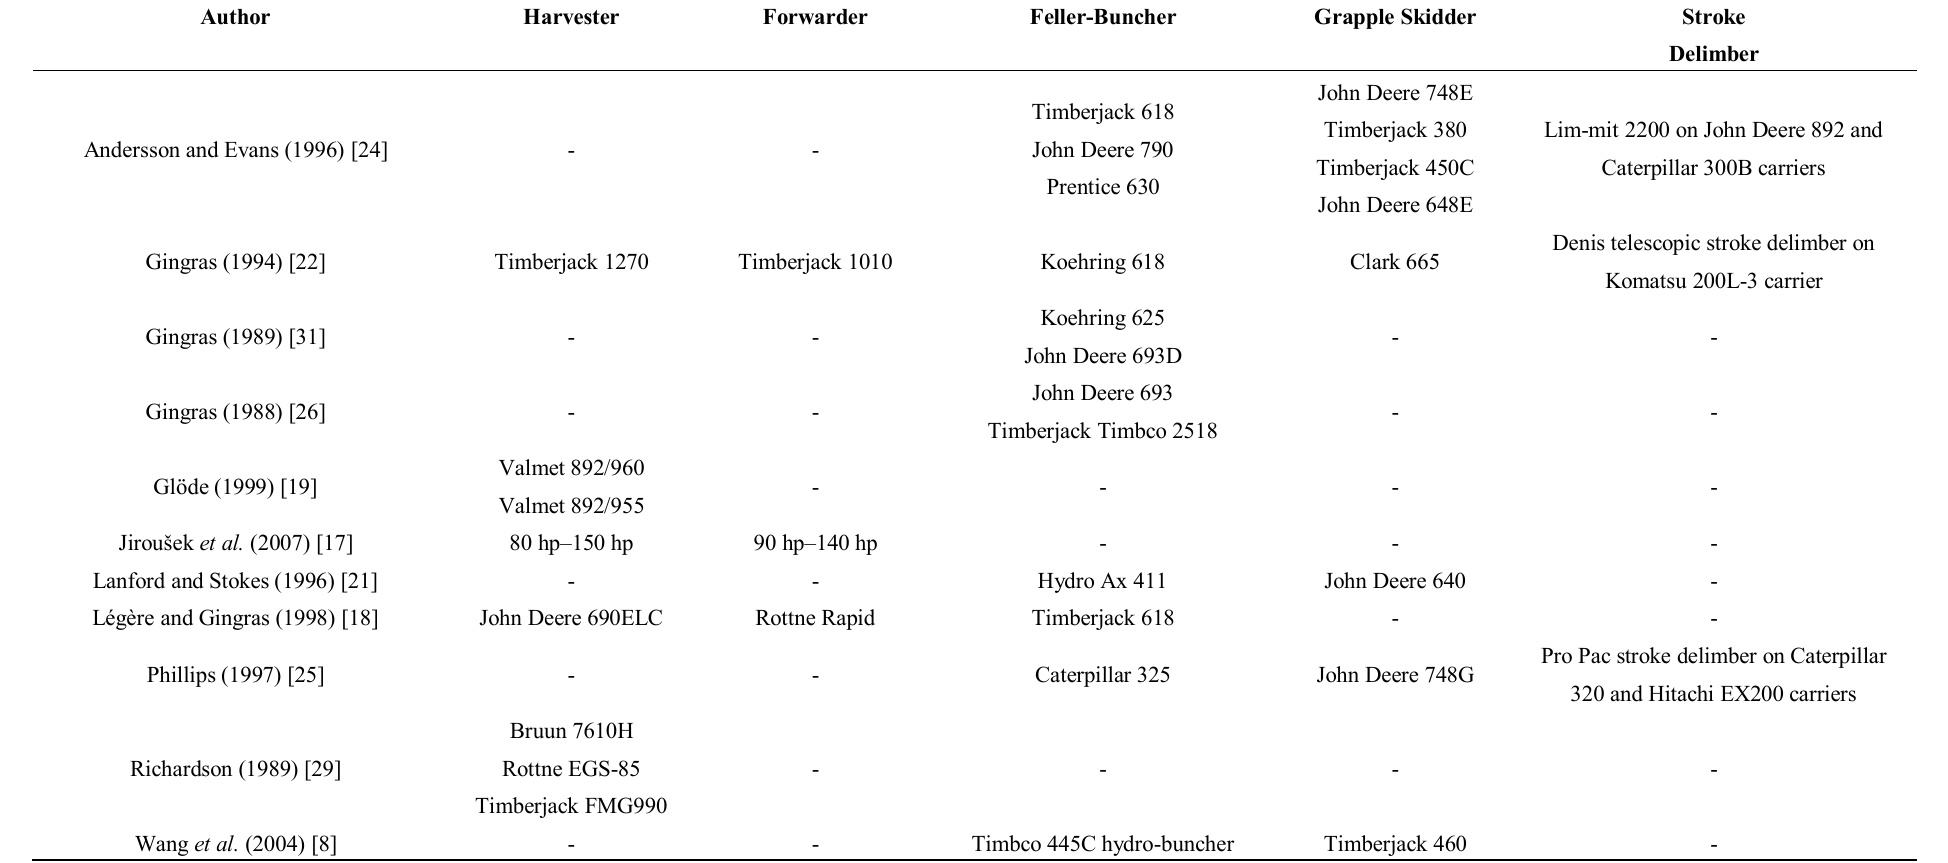
Table 3. Summary of model and make of harvesting equipment used in timber harvesting